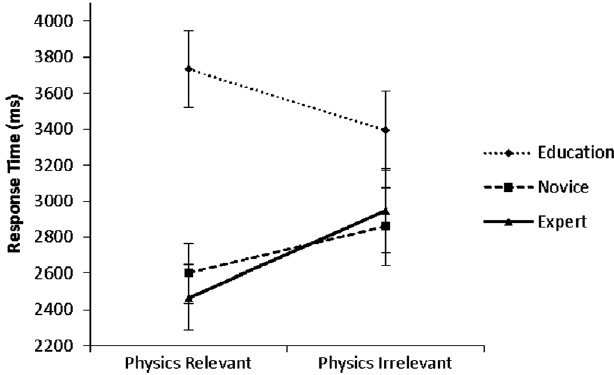
FIG. 2. Mean Response Time for experts, novices, and educa- tion